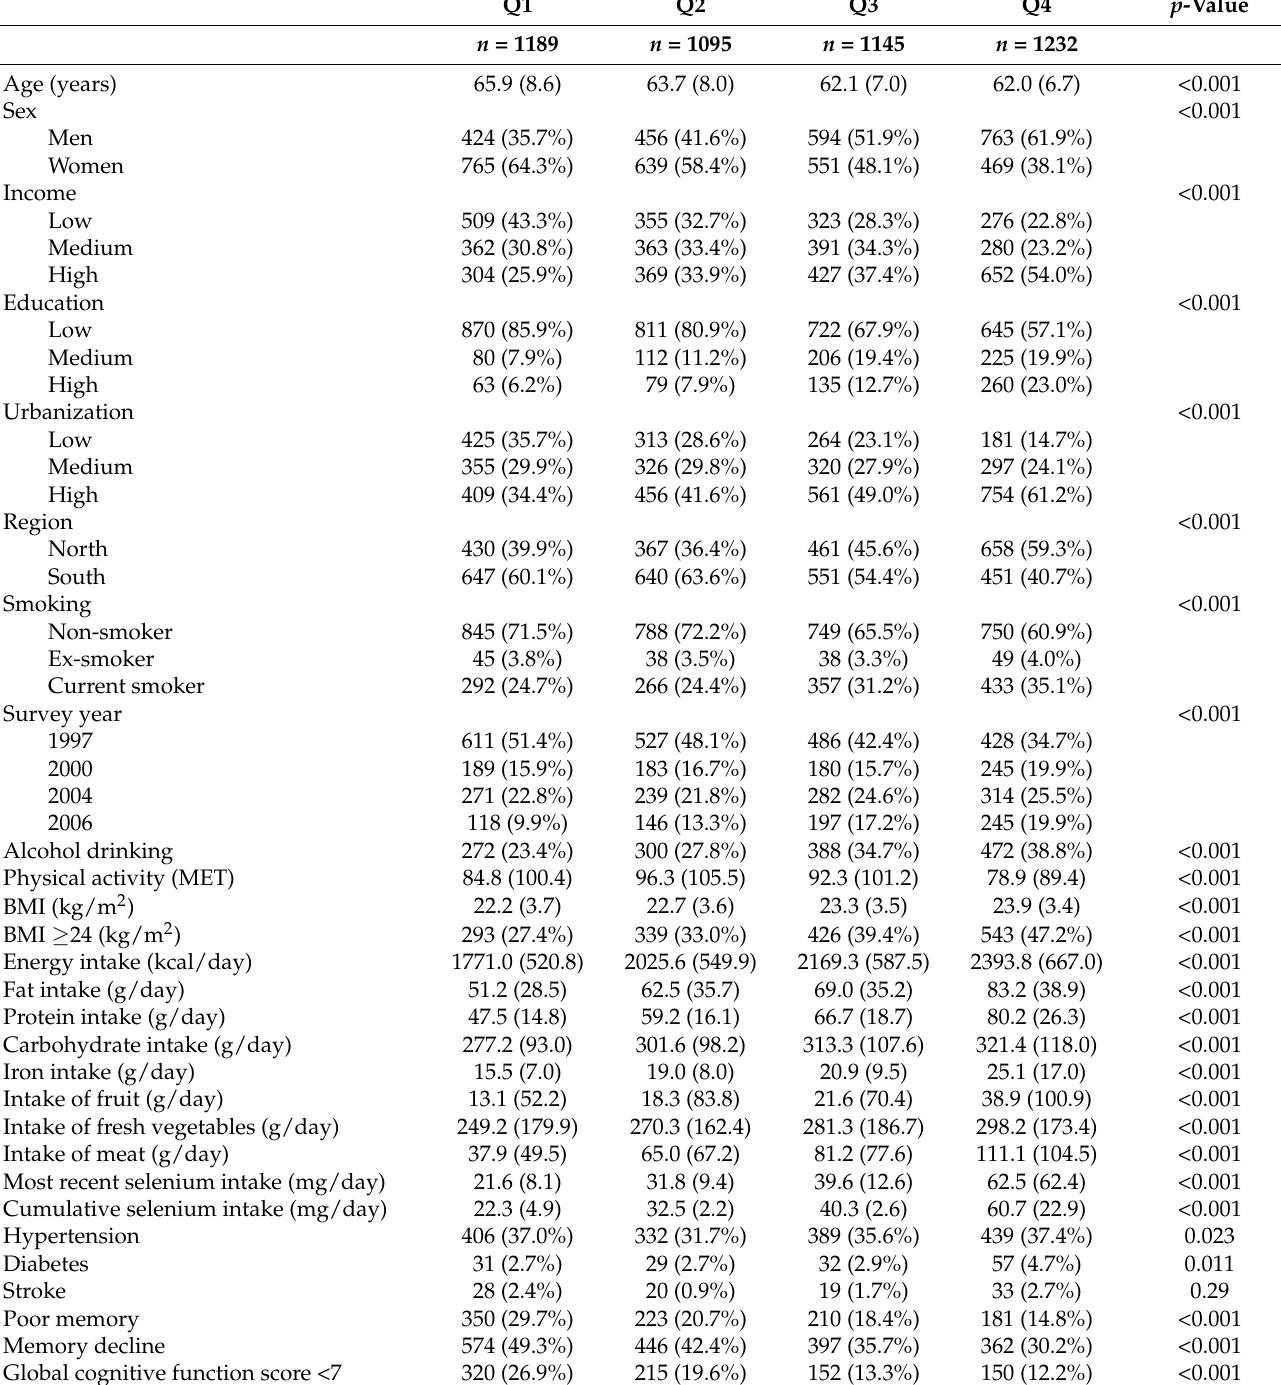
Table 1. Sample characteristics of Chinese adults aged ≥ 55 years old attending the first cognitive function test by quartiles of cumulative selenium intake ( n =